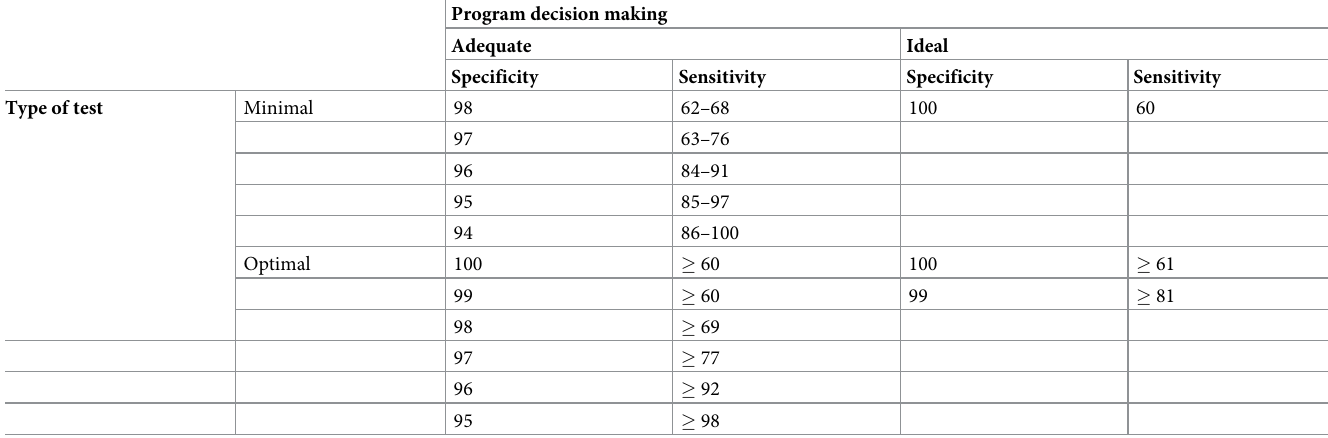
Table 3. The diagnostic performance of minimal and optimal diagnostic tests for adequate and ideal decision making. Diagnostic tests were considered ‘optimal’ when they resulted in level 1 grey zone in at least 3 out of the 6 thresholds and did not result in a level 3 grey zone in any of the 6 program thresholds. In all other cases, the diagnostic test was considered ‘minimal’. For simplicity, we have classified the width of the grey zone into three levels (1–3) for each threshold and ε The classification into these 3 levels was based on the 25 th and 75 th percentile of the width of the grey zones (level 1: width of grey zone < 25 th percentile; level 2: 75 th percentile > width of grey zone � 25 th percentile; level 3: width of grey zone � 75 th percentile (see S1 Table )). For an adequate decision making the ε for ideal decision making this ε overtreat � 10%. For both levels of decision making ε undertreat � 5%.